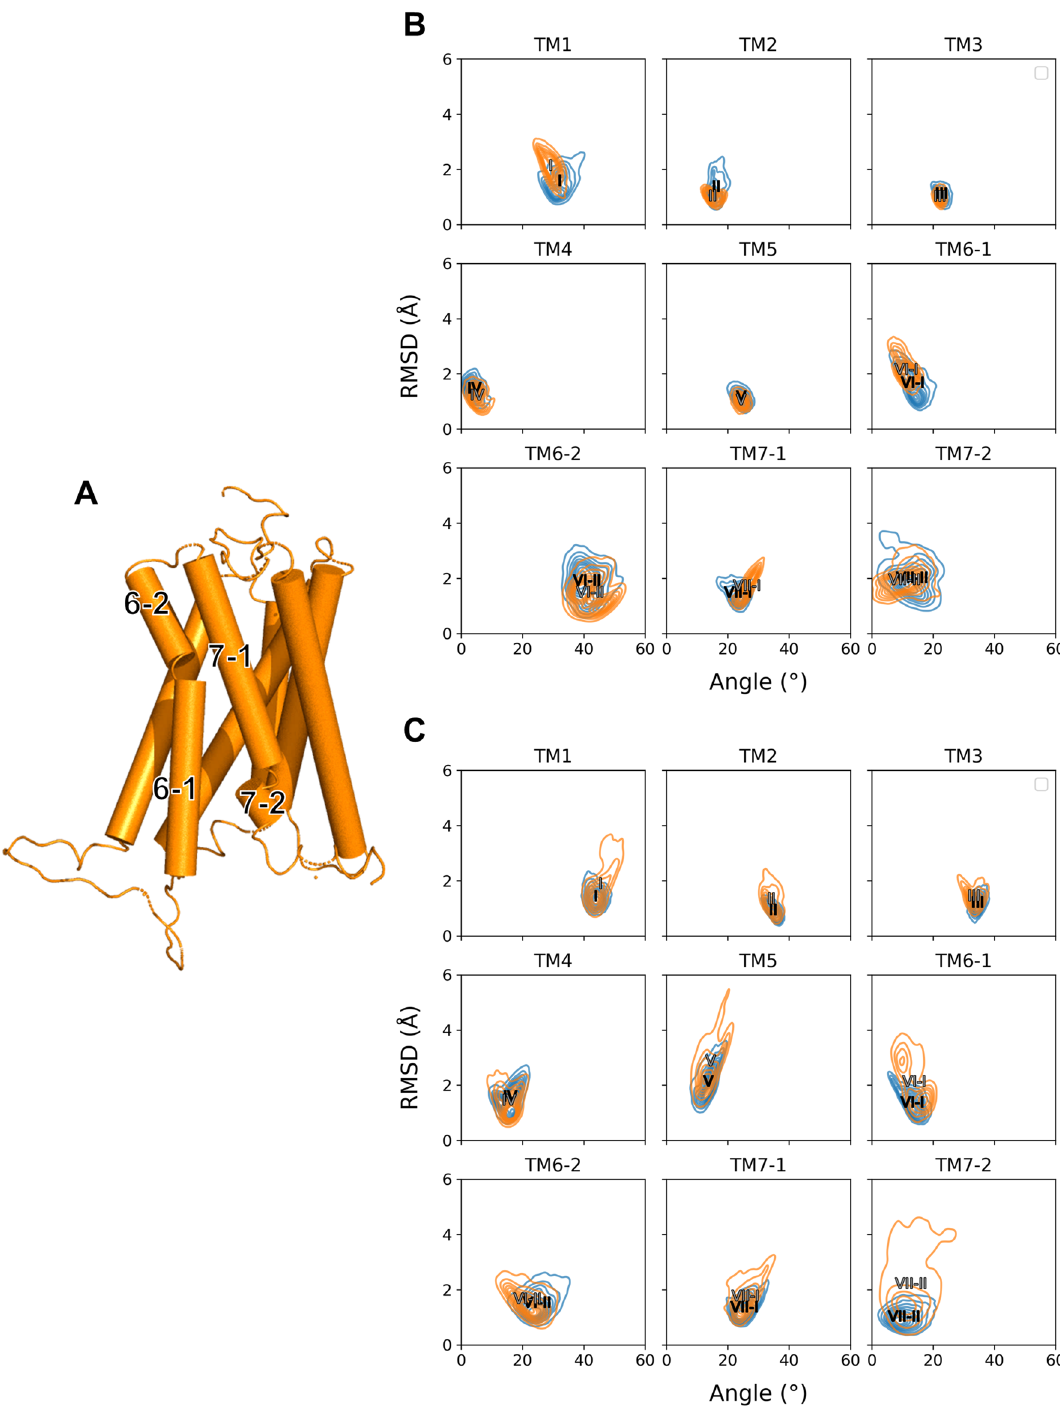
Figure 3. The angle-RMSD distribution for each helix. ( A ) Schematic helical compartments of CB1. Especially, TM6 and TM7 are separated into two compartments by its proline residue as pivot point. ( B , C ) The angle orientation and RMSD of each TM on both wildtype (blue) and mutant (orange) CB1 are plotted for ( B ) active and ( C ) inactive states. The two-dimensional density plot of angle and RMSD are shown over three trajectories for each state. The average point for each TM is marked as its TM index in wildtype (black) and mutant